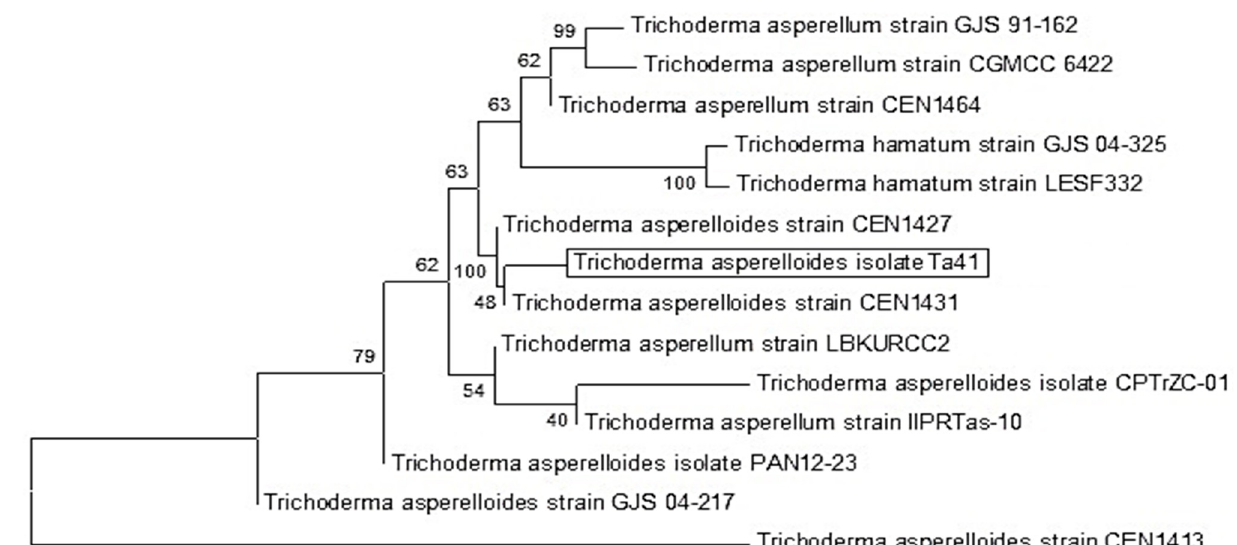
Figure 2. Neighbor-joining phylogenetic tree showing the relationship of T. asperelloides Ta41 isolate (displayed in a rectangle shape) among closely related Trichoderma isolates on partial concatenated sequences of ITS, Tef-1, and Rpb2 available in GenBank (NCBI).